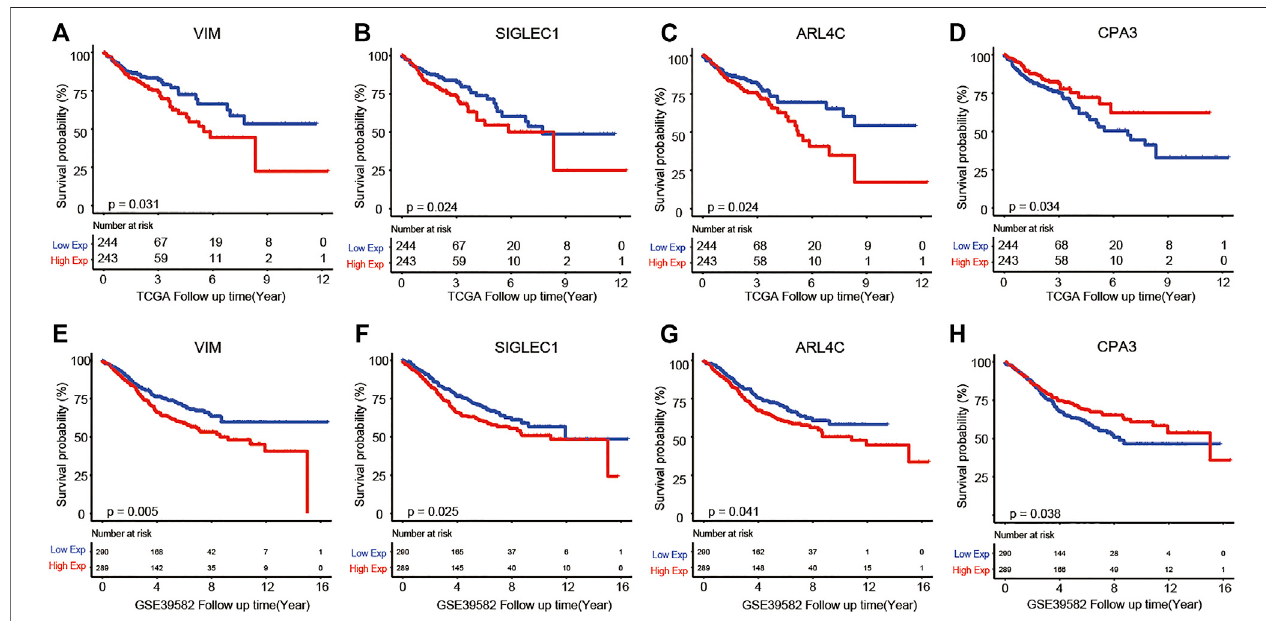
FIGURE 6 | Kaplan – Meier analysis results of VIM (A,E) , SIGLEC1 (B,F) , ARL4C (C,G) , and CPA3 (D,H) in TCGA and GSE39582 datasets.